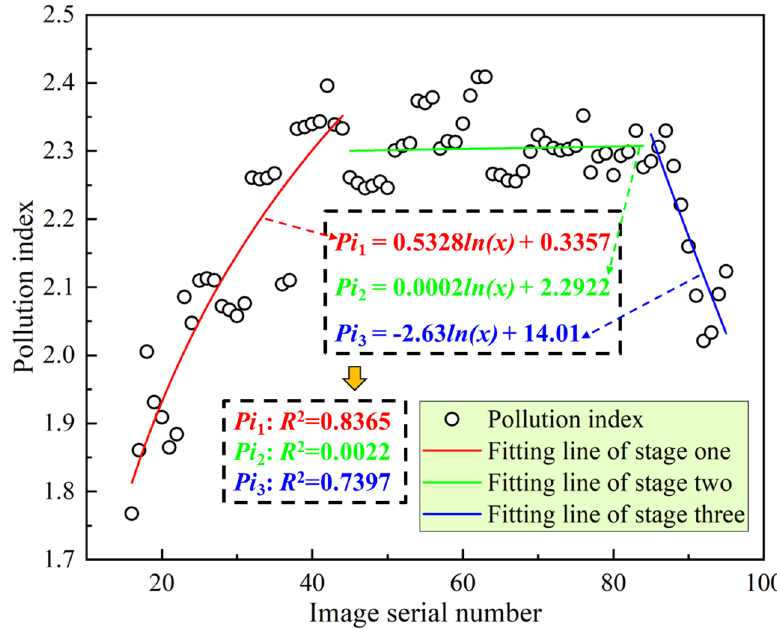
Figure 8. Calculating results of pollution index with fitting curves of pollutants distribution.